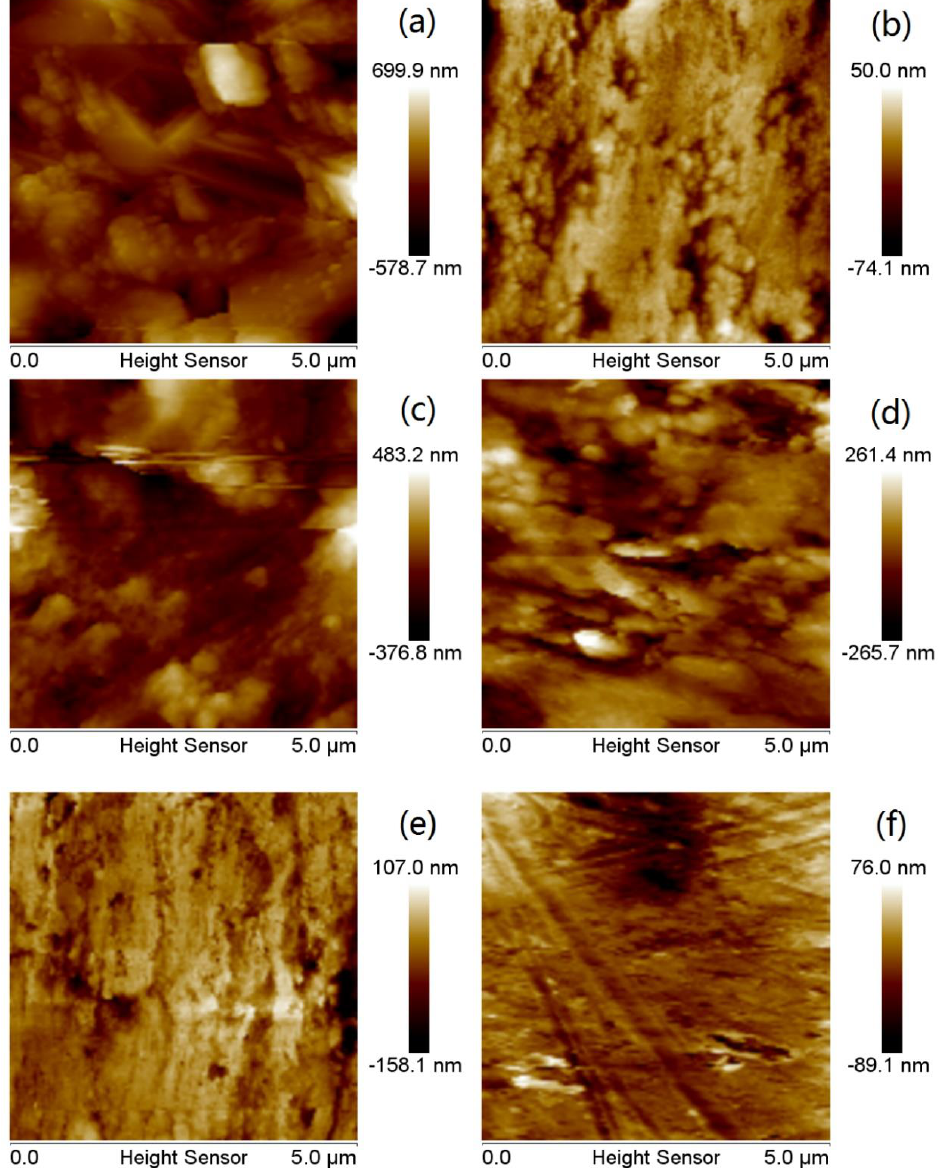
Figure 10. AFM plane topography of N80 steel sheet: ( a ) blank sample; ( b ) initial uncorroded sample; ( c – f ) is added 50 mg/L, 100 mg/L, 200 mg/L, and 300 mg/L MBT.